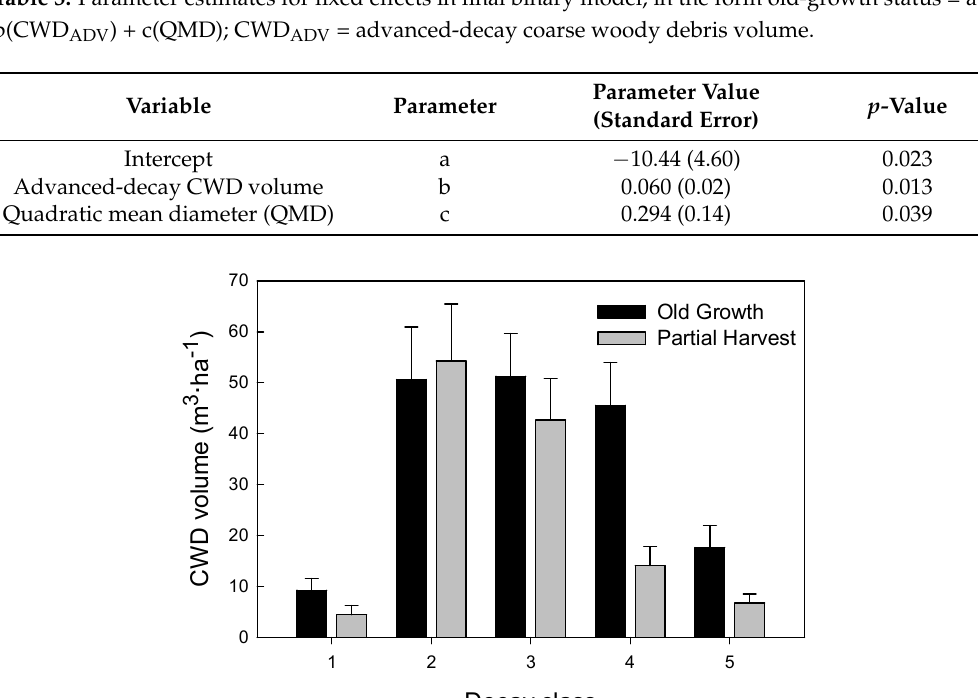
Table 3. Parameter estimates for fixed effects in final binary model, in the form old-growth status = a +